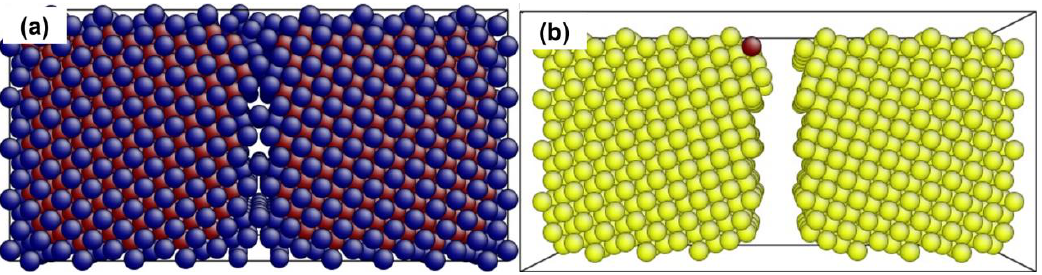
Figure 9. Atomic configurations of the simulation cell at ( a ) point A and ( b ) point B in Figure